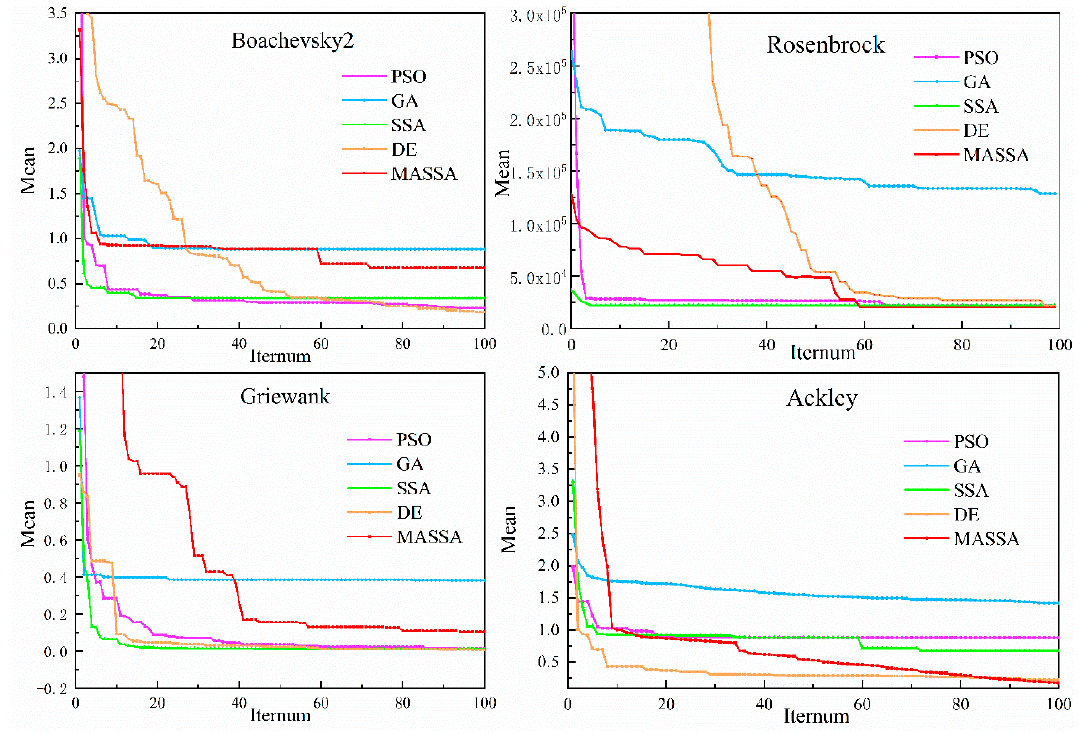
Figure 6. Convergence results 2 of multimodal benchmark functions.